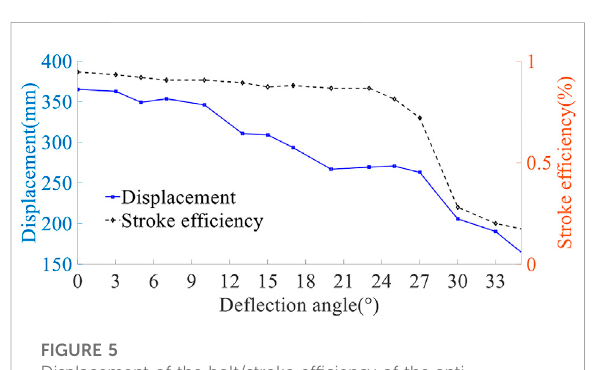
FIGURE 5 Displacement of the bolt/stroke ef fi ciency of the anti- punching device — de fl ection angle